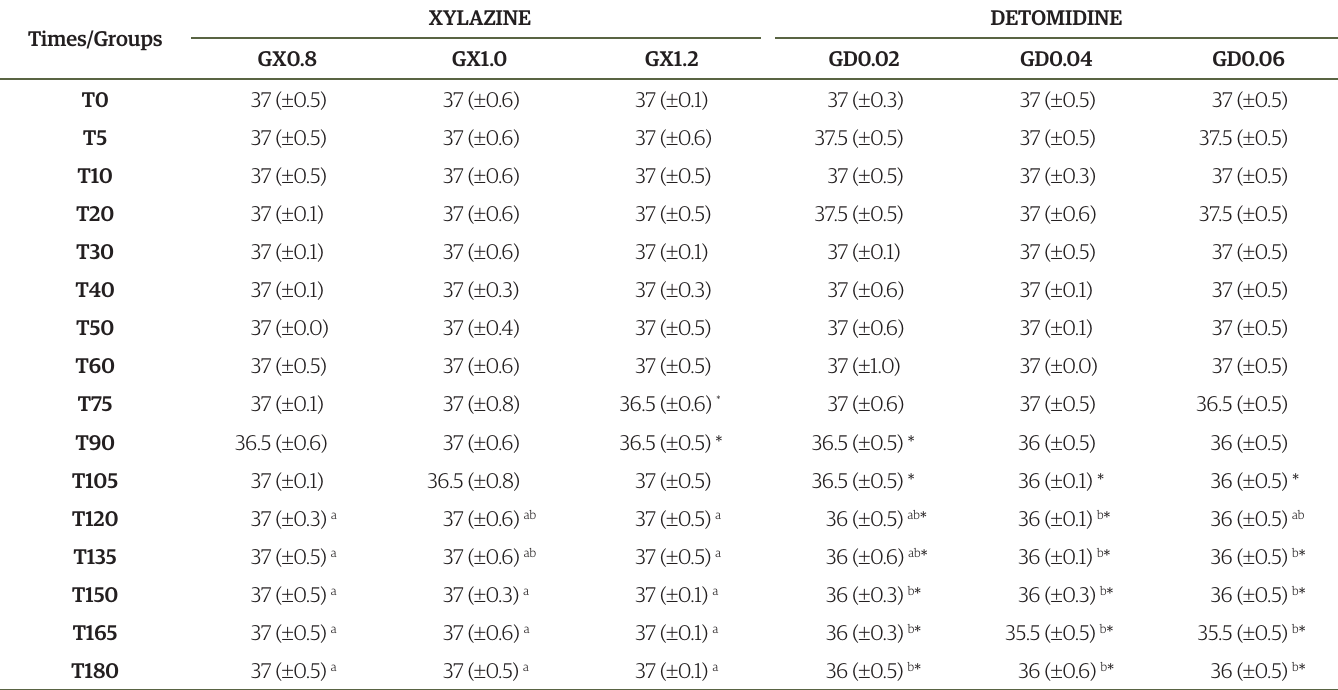
a, b, ab = different letters indicate a significant difference between groups for each moment (p<0.05). * = significant difference for the moment compared to T0